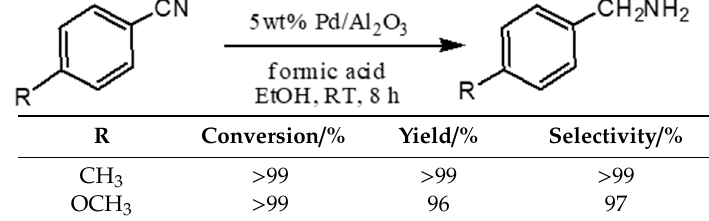
Table 4. Reduction of p -substituted benzonitriles with formic acid using Pd/Al 2 O 3 catalysts.